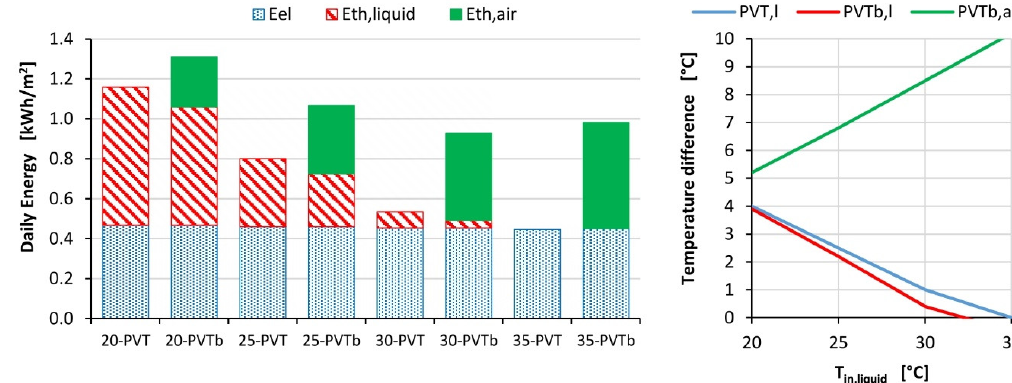
Figure 9. Daily energy yields for WISC and bi-fluid PVT (left), and thermal jump (right) as a function of the inlet water temperatures.